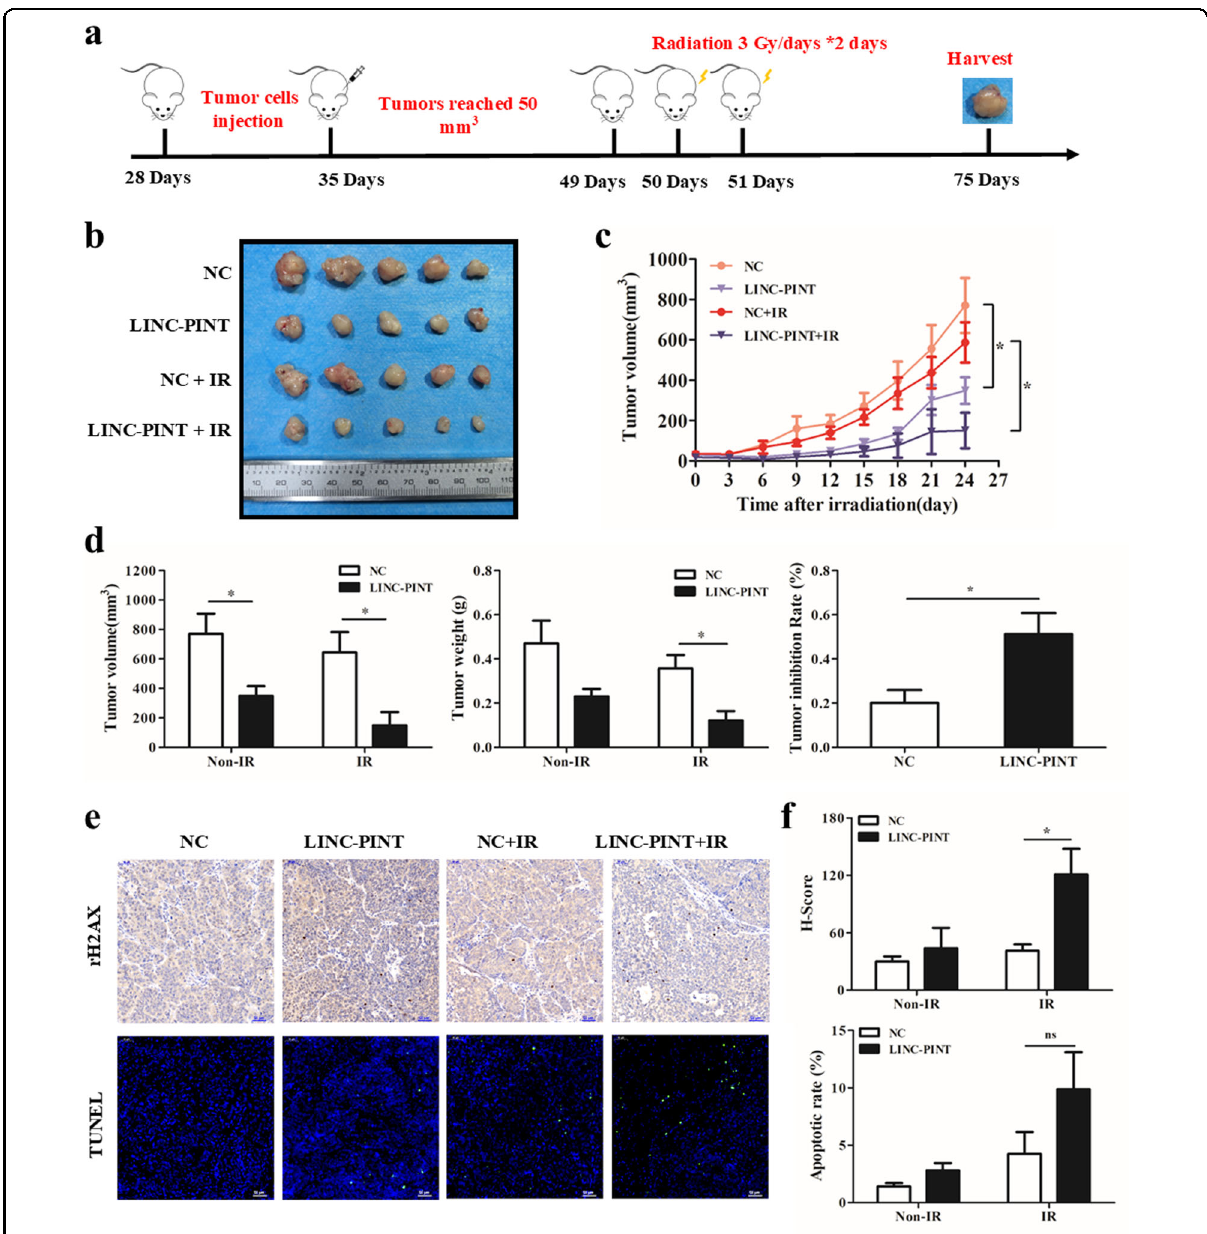
Fig. 3 LINC-PINT is a radiotherapy sensitizer for NPC in vivo. a Treatment schedule in vivo. b Tumor images of xenografts in four groups at the end of the experiment. c Tumor growth curves of xenografts following initiated treatment with irradiation. Each tumor size was monitored and measured three times per week. d The volume (left), weight (middle), and the tumor inhibition rate (right) of xenograft tumors at sacri fi ce were analyzed. e Representative images of immunohistochemical staining for γ H2AX (up) and TUNEL staining for apoptosis (bottom) in LINC-PINT- overexpressing tumors and control group with or without irradiation. Scale bar = 50 μ m. f Quanti fi cation of γ -H2AX staining (up) and TUNEL staining (bottom) in four groups. Data represent the mean ± SEM. Statistical signi fi cance was calculated using a two-sided t test. * P < 0.05, ** P < 0.01, *** P <